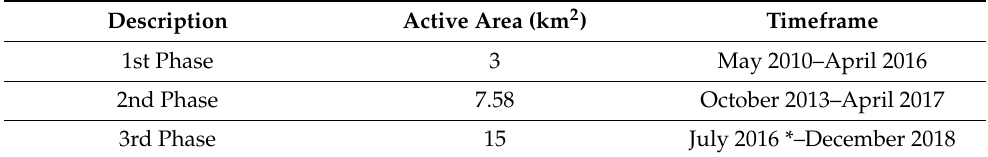
Table 1. Main phases of land reclamation for Xiang’an Airport.